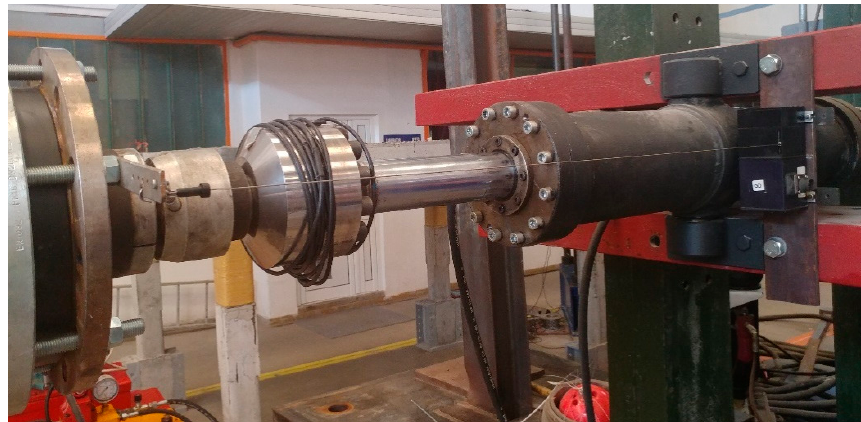
Figure 4. AEP 100 kN Force Cell and Celesco PT5AV wire displacement transducer.